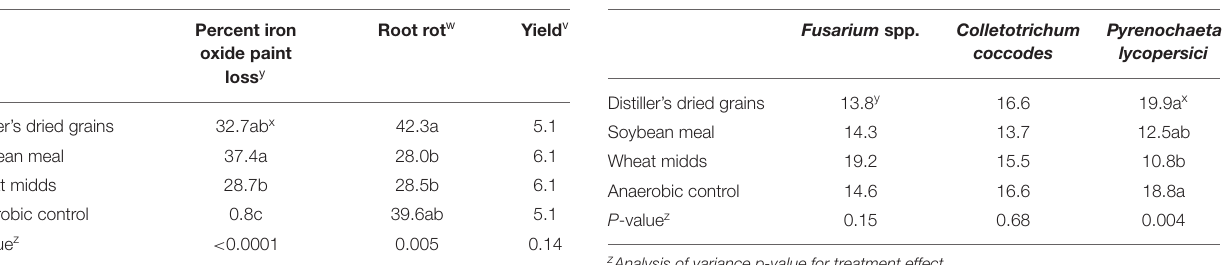
TABLE 4 | Mean soil reducing conditions, root rot severity, and yield from on-farm trials conducted to assess three anaerobic soil disinfestation carbon sources (20.2 Mg/ha).